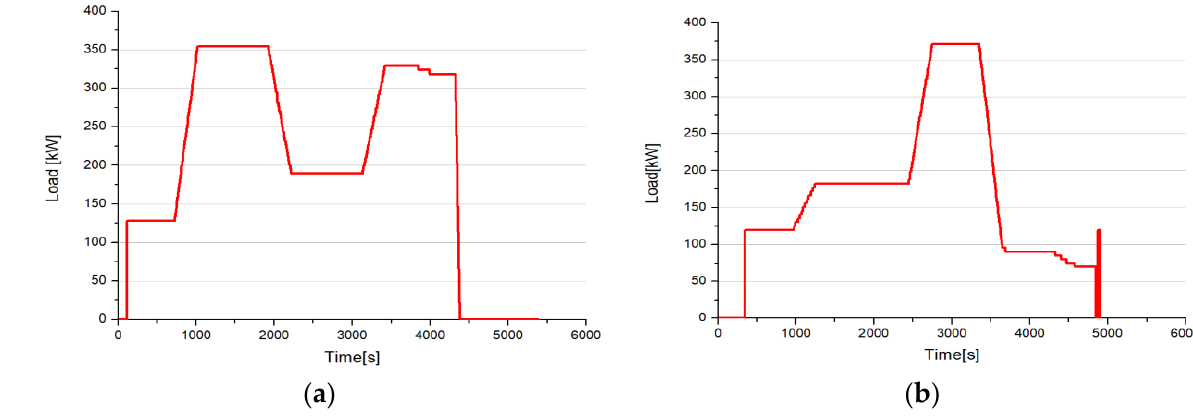
Figure 4. Load profiles for the reference container ships; ( a ) 5,500 TEU ( b ) 13K